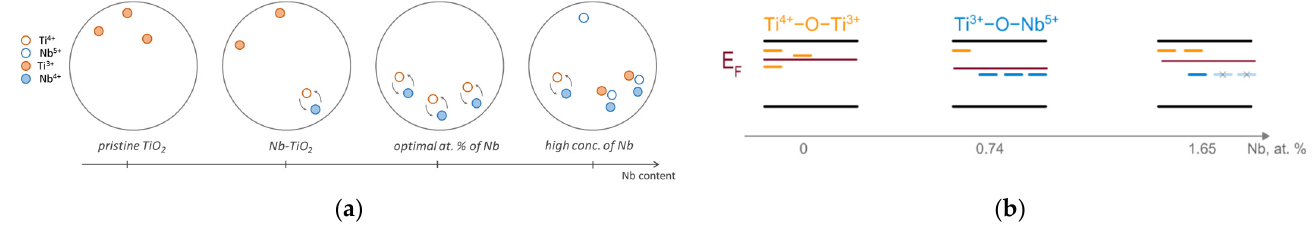
Figure 8. Illustration of the ( a ) spatial and ( b ) energy redistribution of the defect states in Nb-doped TiO 2 . Yellow dashes are Ti 4+ -O-Ti 3+ states, blue dashes are Ti 3+ -O-Nb 5+ states.